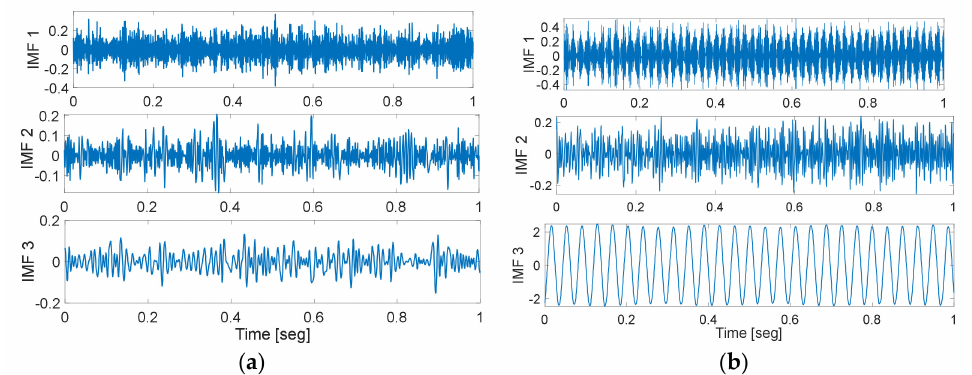
Figure 7. Intrinsic Mode Functions (IMFs) decomposed components using Empirical Mode Decomposition (EMD) from: ( a ) vibration signals and ( b ) current signals.